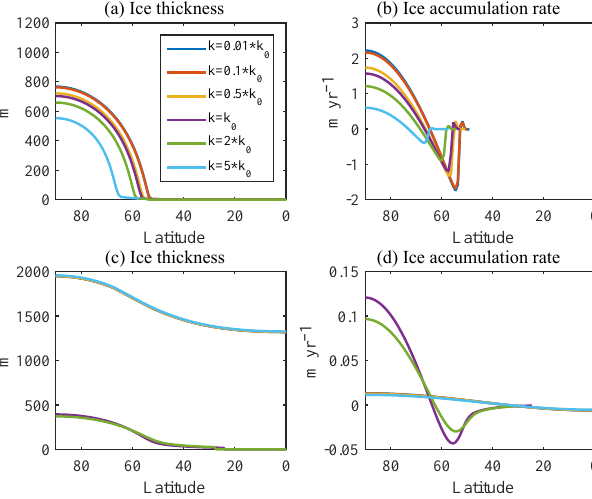
Figure 5. Effect of D parameter on equilibrium climate state, small ice cap regime ( ε = 0 . 75, top), and large ice cap regime ( ε = 0 . 82, 94% insolation, F geo = 0 . 08Wm − 2 bottom). There is a particu- larly strong response in the resulting melting/accumulation term which was used to constrain the value of D . Furthermore, the insta- bility near the large ice cap threshold is reflected in nearby values of D to the default D = 0 . 05, resulting in global ice cover for ε = 0 . 82. Note that the discontinuity in ice accumulation rate for D = 0 . 1 is an artifact of the regularization of Eq. (10) as h approaches 0.